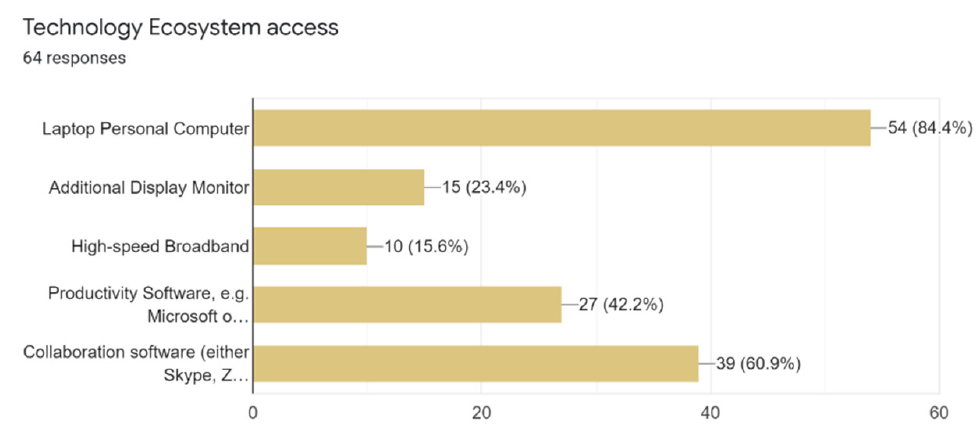
Figure 4. The two most significant difficulties in working from home (WFH). Source: online survey that took place between December 2020 and March 2021. N: 64.